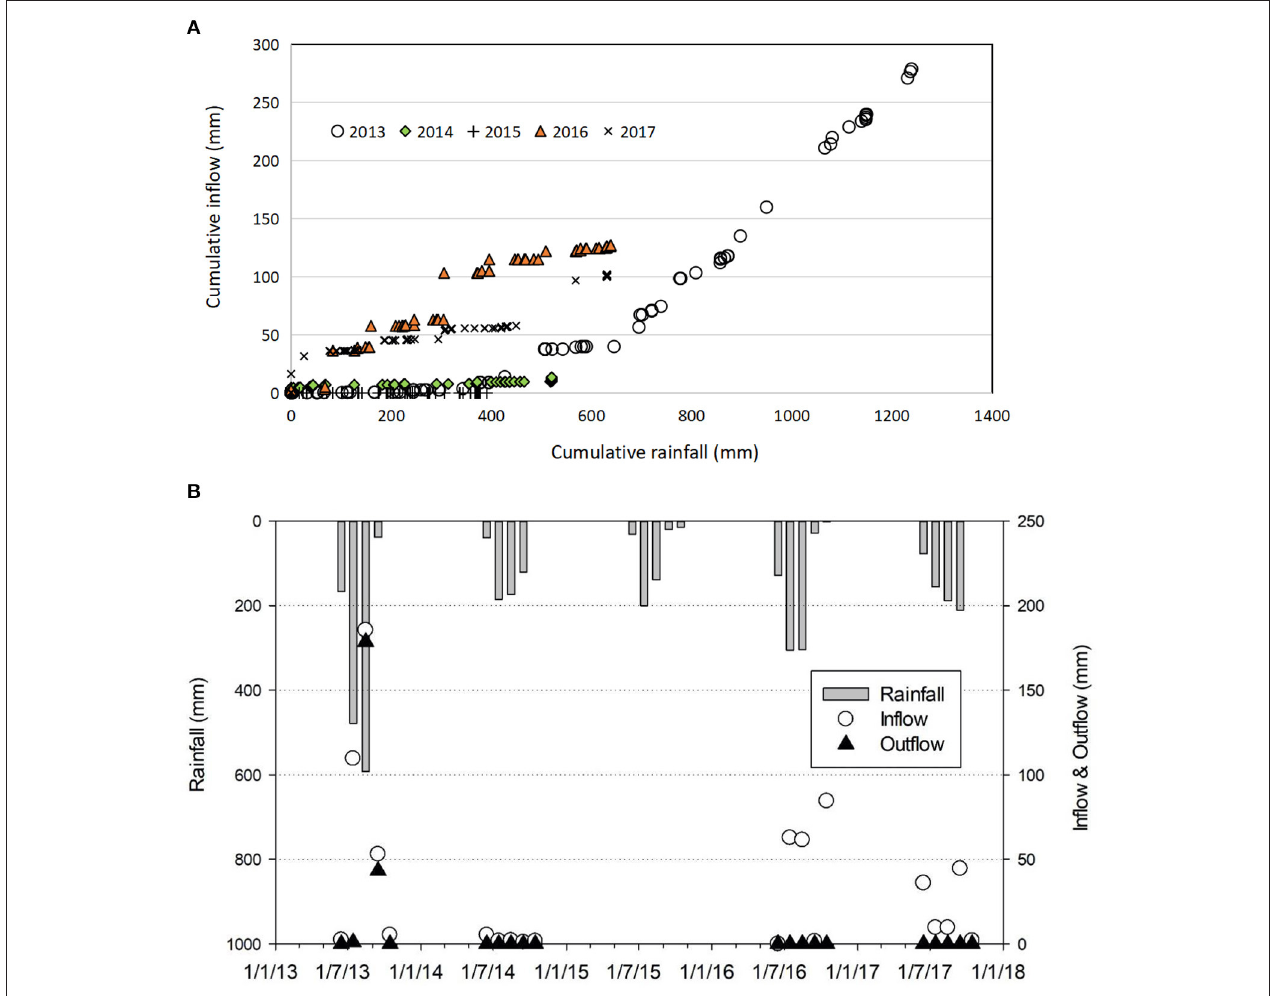
FIGURE 5 | (A) Cumulative rainfall vs. inflow at Haveli structure; (B) Inflow and outflow in different years.